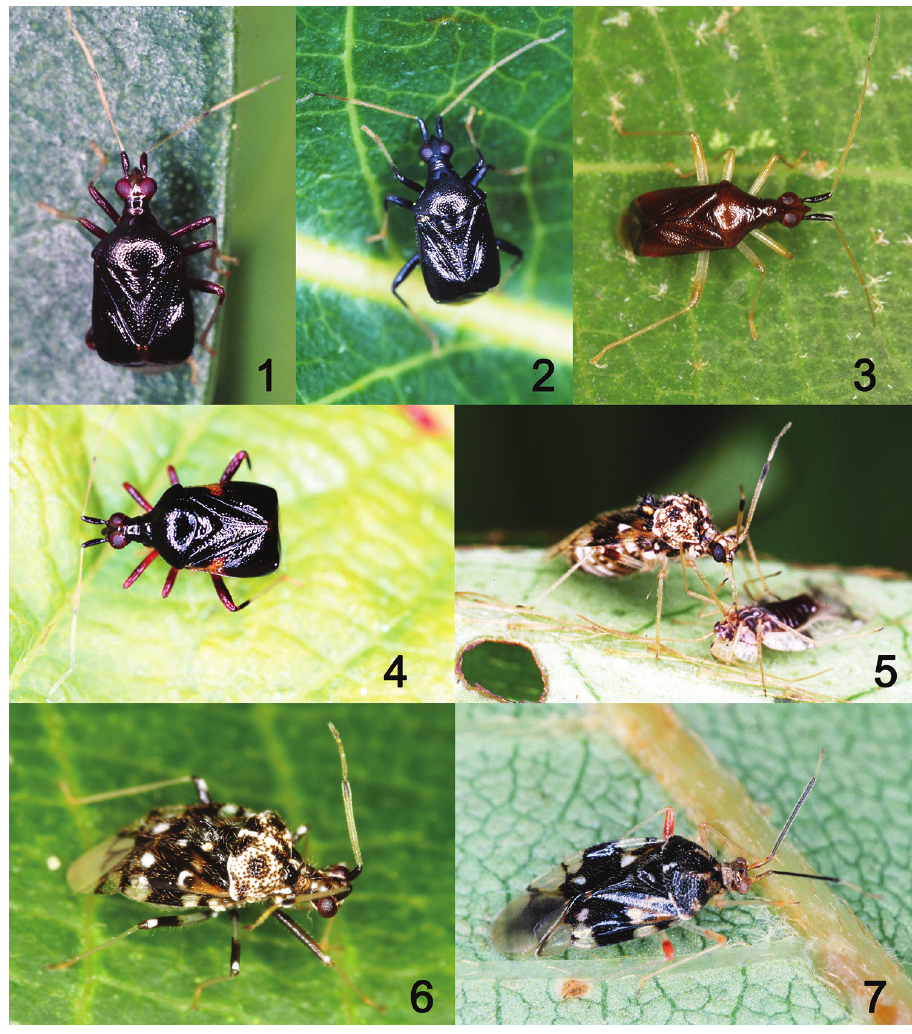
Figures 1–7. Habitus images of Fingulus spp. and Stethoconus spp. from Japan. 1 F. collaris from Ishigaki Island. Ryukyus 2 F. longicornis from Amami Island, Ryukyus 3 F. takahashii from Ishigaki Island 4 F. henry- tomi sp. n. from Kochi, Shikoku, holotype, female 5 S. japonicus preying on Stephanitis pyrioides (Scott) (Tin- gidae), from Ibaraki, Honshu 6 S. praefectus form Ishigaki Island 7 S. takaii from Kochi, Holotype,